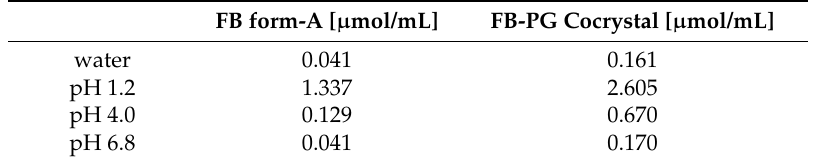
Table 2. Solubility comparison of FB-PG cocrystal and FB form-A in water and at pH 1.2, 4, and 6.8.